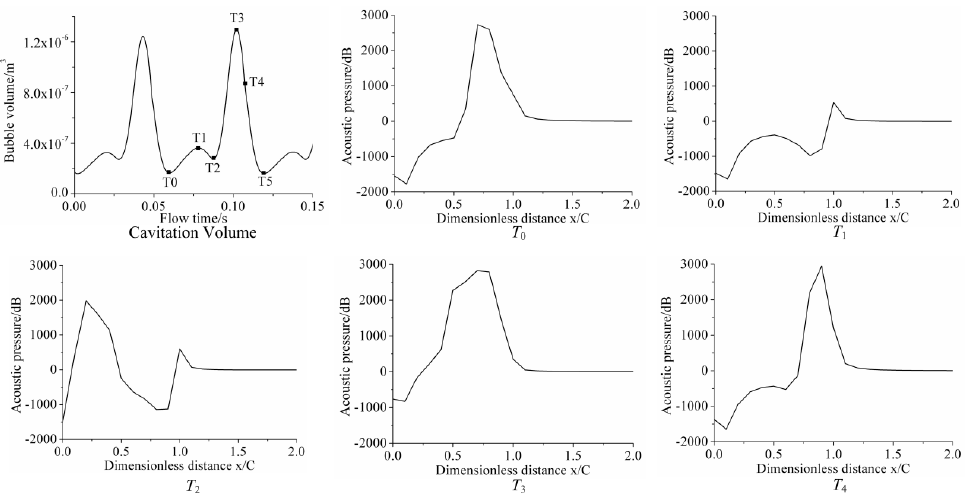
Appl. Sci. 2019 , 9 , x FOR PEER REVIEW Figure 17. Acoustic pressure at different flow times for σ = 0.55. Figure 17. Acoustic pressure at di ff erent flow times for σ = 0.55.